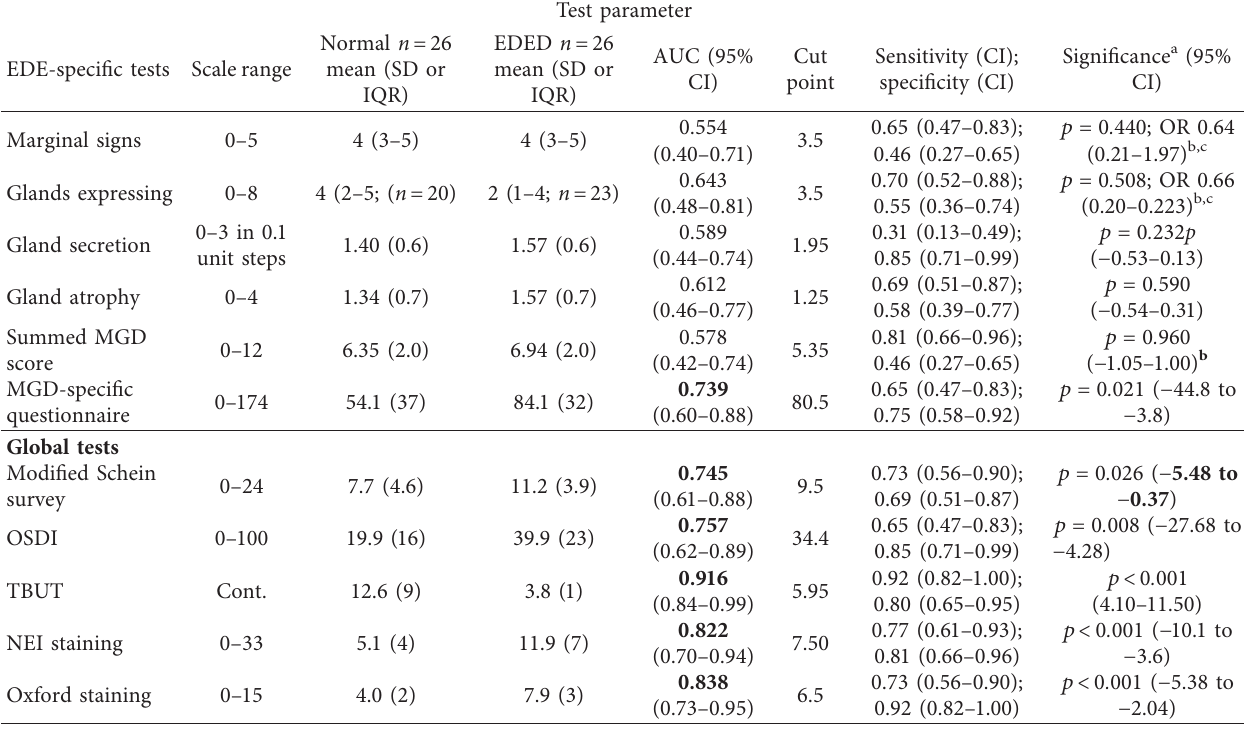
Table 1: Efficacy study: test values and diagnostic parameters of EDED-specific and global dry eye tests. Test parameter